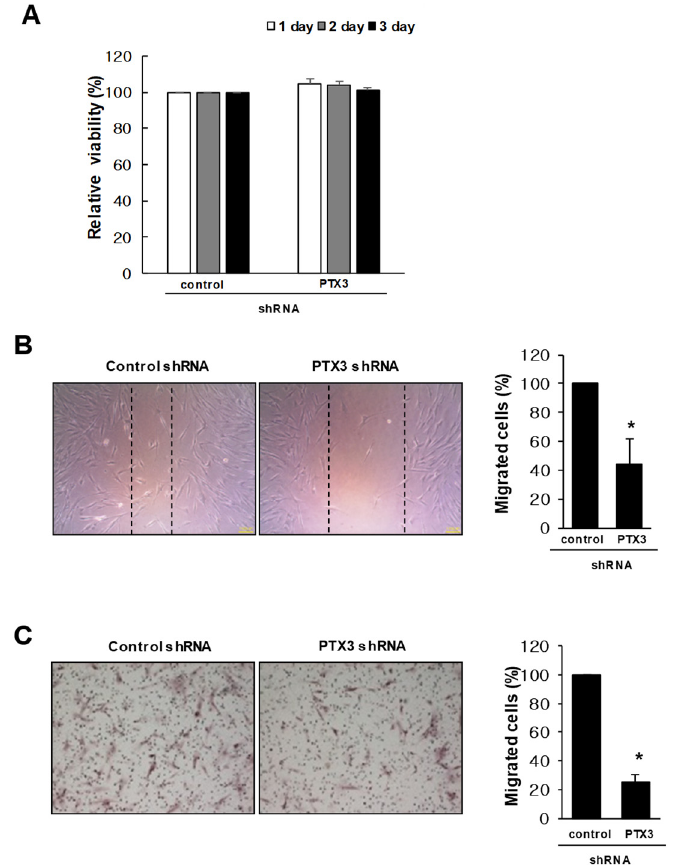
Figure 3. E ff ect of PTX3 knockdown on migration in human dental pulp stem cells. ( A ) The proliferation of HDPSCs, which were stably transduced with either PTX3 shRNA or the negative control shRNA, was determined by MTT assay. ( B ) Scratch wound migration assay was performed using HDPSCs that were stably transduced with either PTX3 shRNA or the negative control shRNA. After incubation for 24 h, migrated cells were observed with a phase contrast microscope at 100 × magnification. The number of cells that migrated beyond the reference line was counted. Each result represents the mean value from triplicate experiments in each group. ( C ) Control shRNA-transduced or PTX3 shRNA-transduced HDPSCs were incubated in transwell upper chambers for 24 h. The migrated cells were stained with hematoxylin–eosin, photographed, and counted. * p < 0.05 compared to control shRNA-transduced HDPSCs.